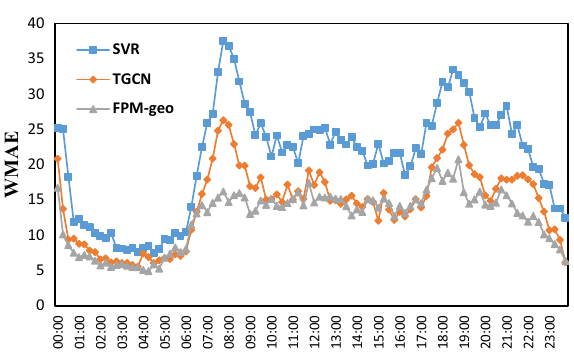
Figure 18. Time distribution of the WMAE of each